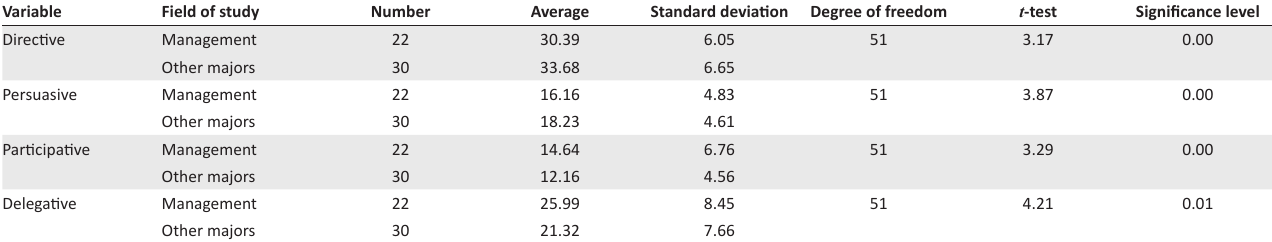
TABLE 5: Studying the difference between leadership styles, with respect to the managers’ field of study. Variable